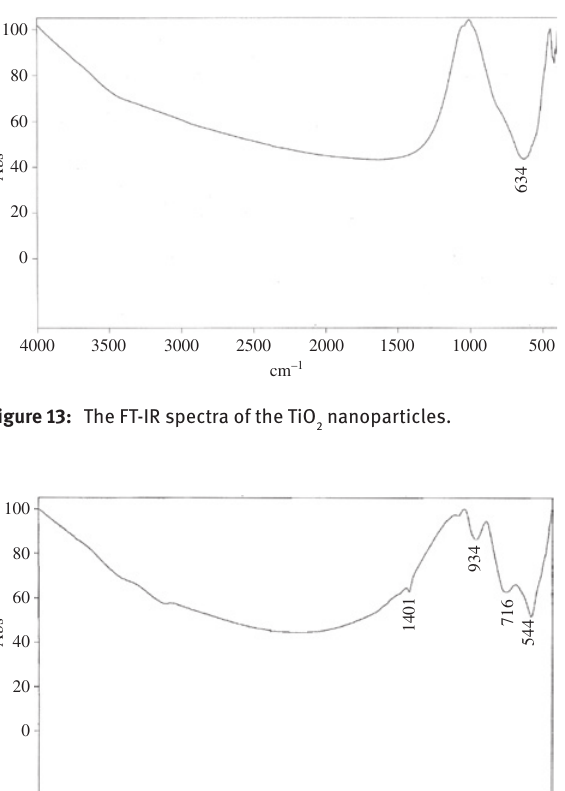
Figure 14: The FT-IR of the PbFe